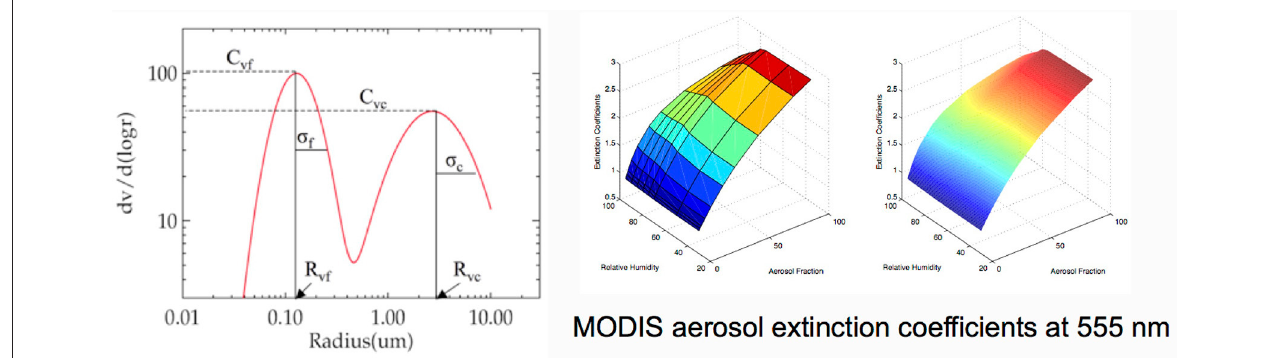
FIGURE 1 | SeaDAS bimodal aerosol model (Ahmad et al., 2010). (Left) Size distributions of the fine and coarse aerosol modes which are assumed to be log-normally distributed in volume space with a fixed width of 0.437 for the fine mode and 0.672 for the coarse mode. (Middle) The ten different aerosol fine mode fractions in volume space: f V = 0, 1, 2, 5, 10, 20, 30, 50, 80, 95%, and eight different relative humidities: 30, 50, 70, 75, 80, 85, 90, 95%. We used the SeaDAS median radius at a relative humidity of 70% for this study. Thus the fine mode mean radius was 90 nm, and the coarse mode median radius was 755 nm. And for this study the fine mode complex refractive index was set to that of 100% soot to represent an absorbing particle. (Right) “Continuum” of models obtained by interpolation between the discrete SeaDAS models. Note that the aerosol fine mode fraction in volume space was retrieved in this study, except it was expressed in terms of the fine mode optical depth